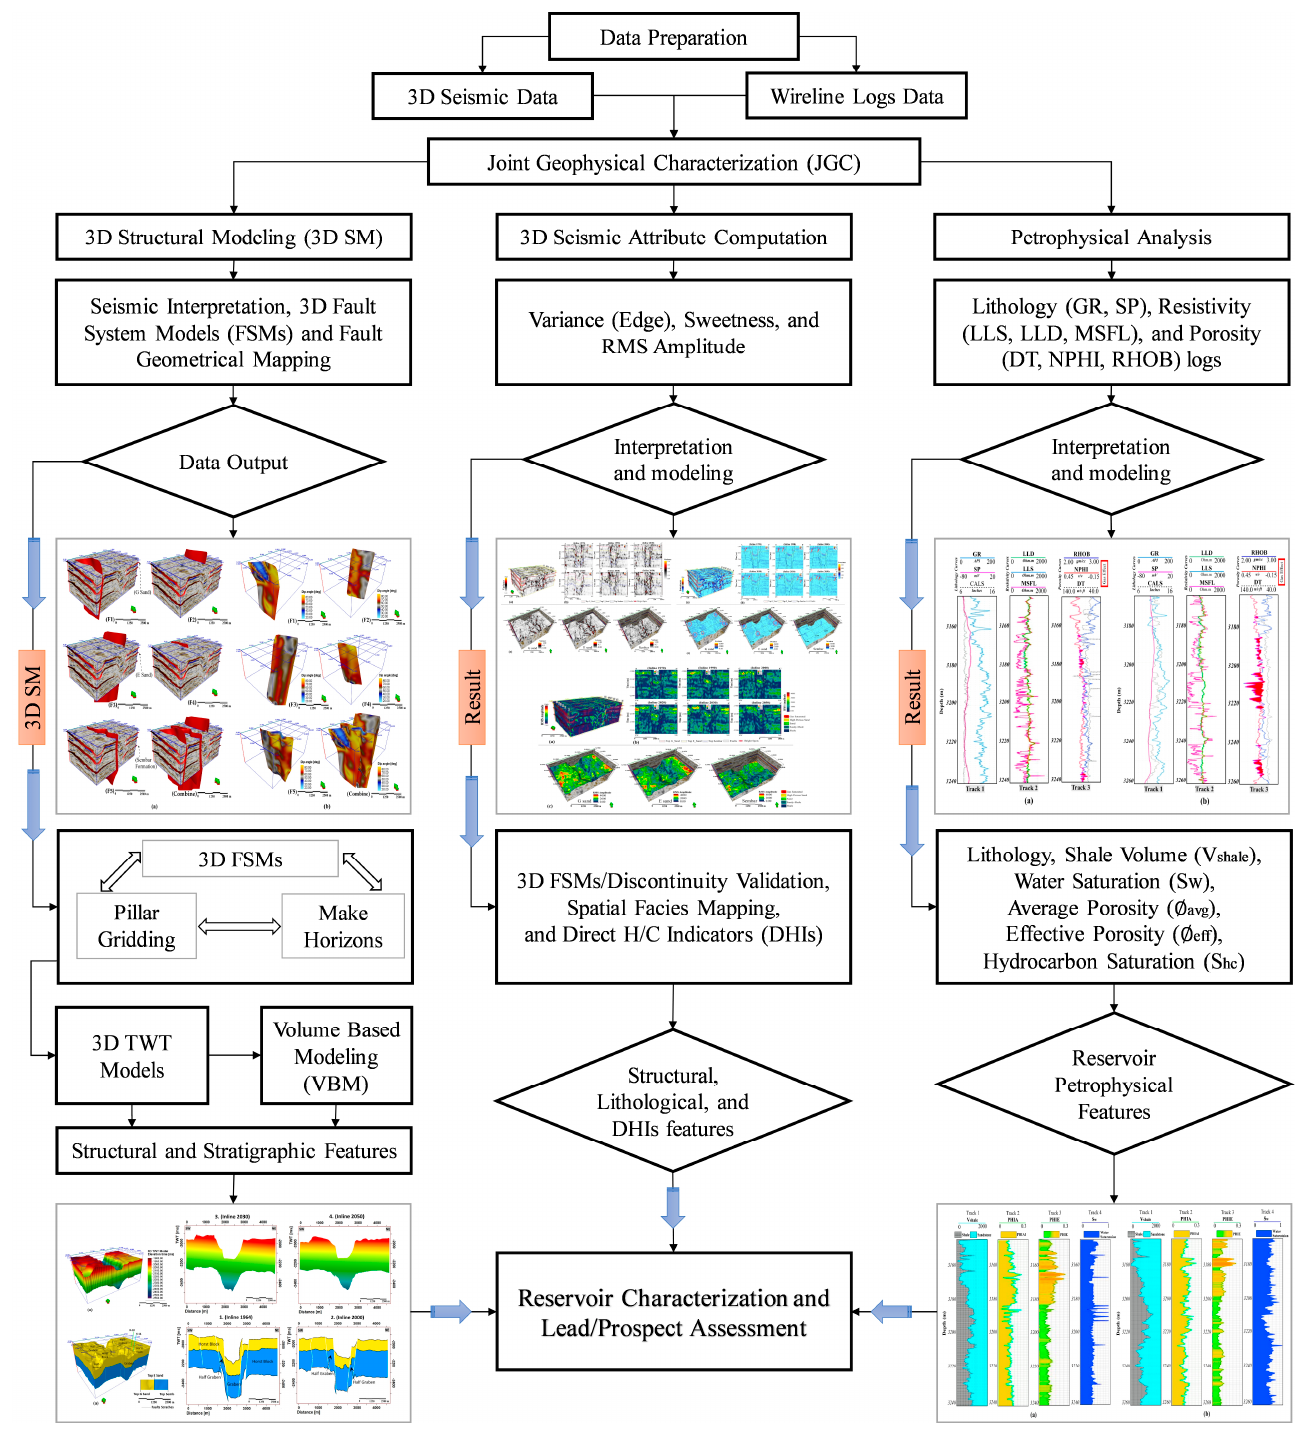
Figure 3. Workflow highlighting various steps and methods employed in this study for reservoir characterization and prospect assessment of the Kadanwari field, MIB, Pakistan. characterization and prospect assessment of the Kadanwari field, MIB,